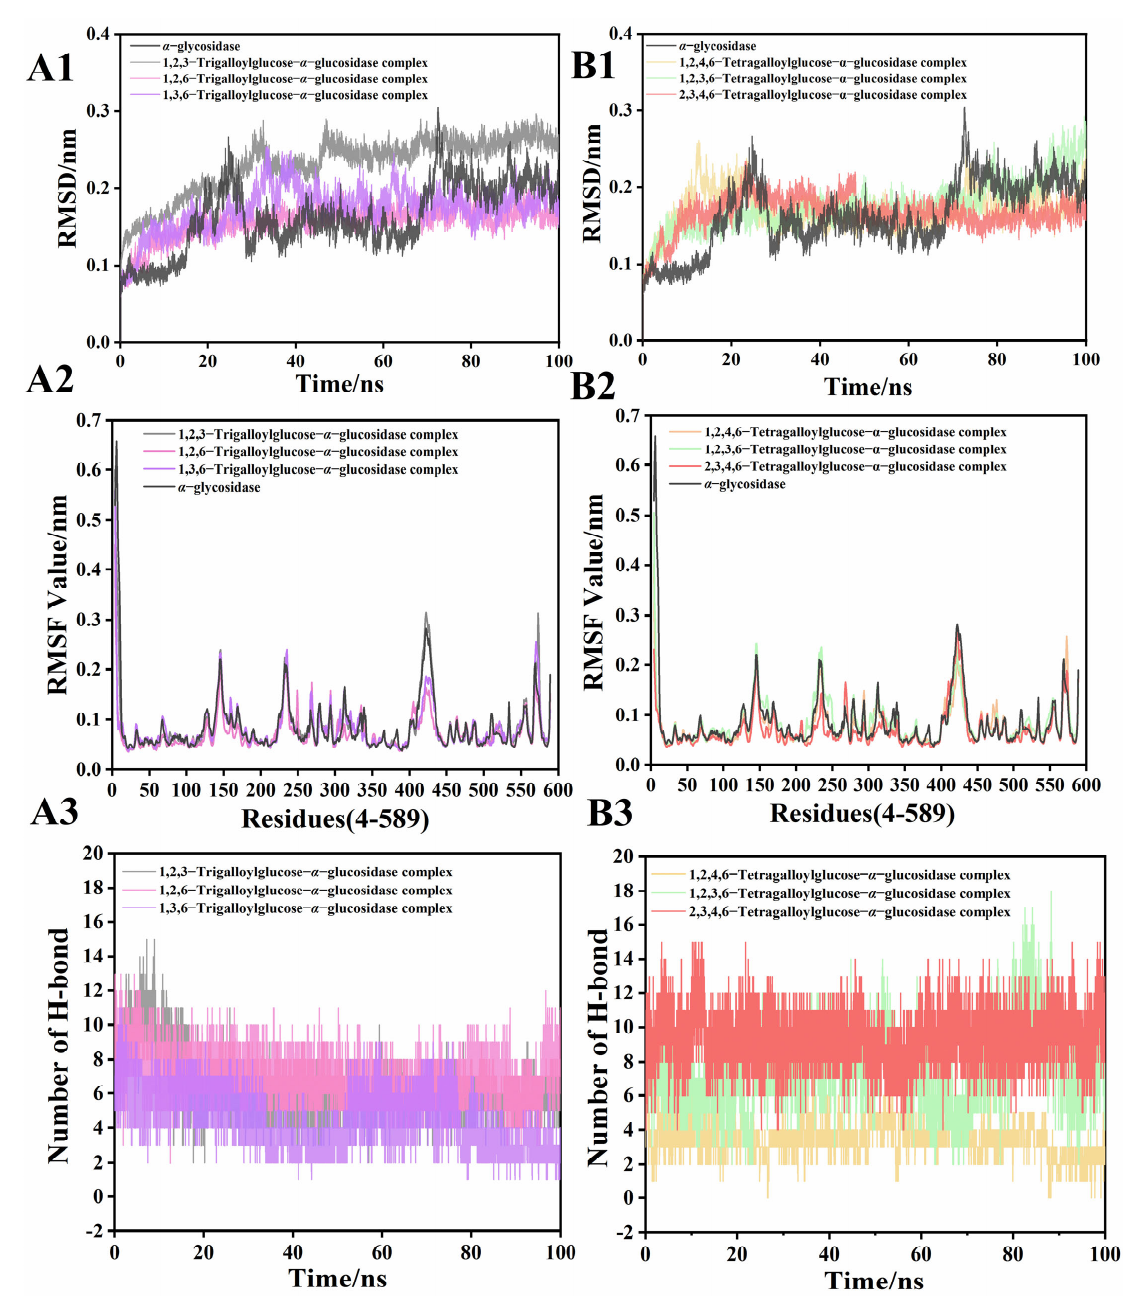
Figure 6. Molecular dynamics (100 ns) results of three different structures of trigalloylglucose and α‐ glycosidase complexes ( A ) or three different structures of tetragalloylglucose and α‐ glycosidase complexes ( B ). ( A1 , B1 ) represent the root mean square deviations (RMSD, nm). ( A2 , B2 ) represent the root mean square fluctuations (RMSF, nm). ( A3 , B3 ) represent the number of hydrogen bonds (H ‐ bonds, number) of three different complexes and α‐ glycosidase alone at 100 ns molecular kinetics, respectively.